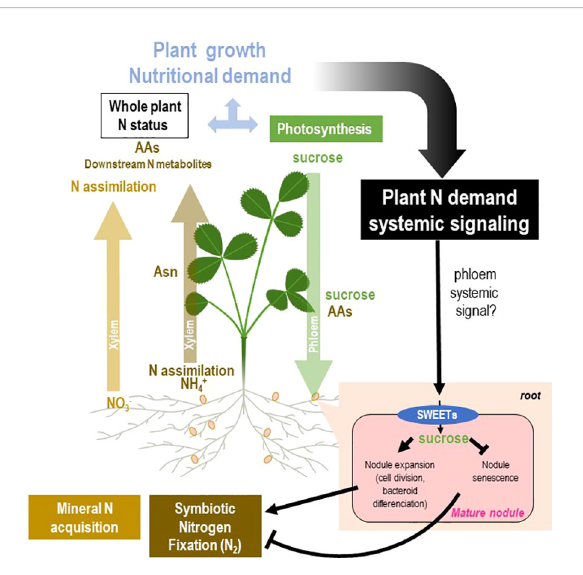
FIGURE 7 Model of systemic regulation of mature nodules by N demand through nodule sucrose allocation. The general framework of the fi gure is described in Figure 2. Split-root systems used to characterize N-demand signaling are described in Figure 3. Systemic control of mature nodule development and activity by the whole plant N demand is associated with variation of the allocation of sucrose produced by the photosynthesis to the mature nodule. The hypothetical systemic signal(s) translocated through the phloem remains unknown. On the one hand, the systemic N-satiety signaling lowers nodule sucrose levels and triggers nodule senescence. On the other hand, the systemic N-de fi cit signaling increases nodule sucrose levels and stimulates nodule expansion. This differential sucrose allocation associates with variations of the SWEET sucrose ef fl ux transporter transcript levels in response to N- satiety and N-de fi cit systemic signaling.